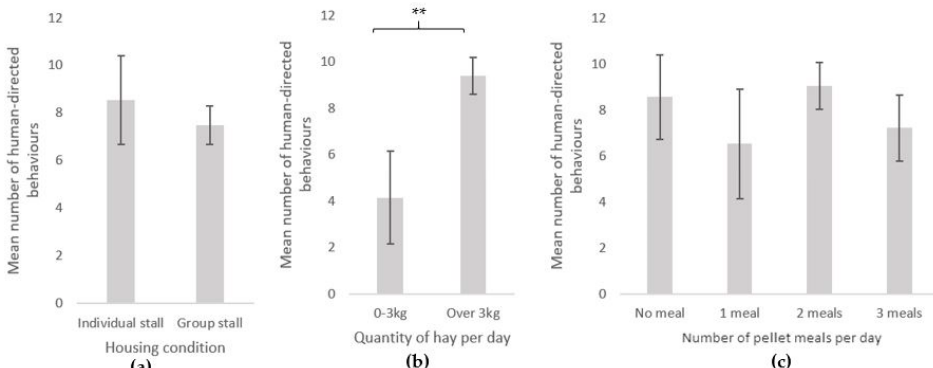
Figure 4. Human-directed behaviours (mean ± SE) during the motionless person test according to equids’ conditions of life parameters: ( a ) housing condition (individual stall: N = 134, group stall: N = 38; ( b ) hay quantity per day (0–3 kg: N = 35, Over 3 kg: N = 137); ( c ) Number of pellet meals per day (No meal: N = 39, 1 meal: N = 17, 2 meals: N = 81 , 3 meals: N = 35). GLM negative binomial. **: p < 0.01.